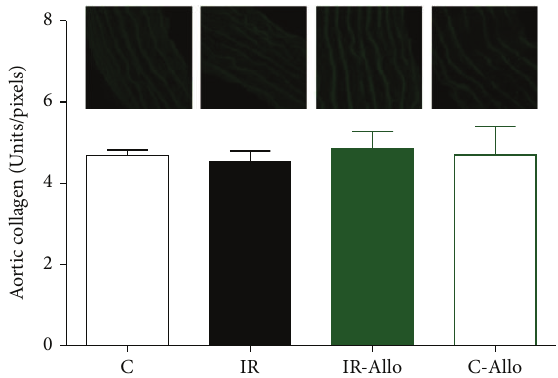
Figure 8: The effect of allopurinol (Allo) treatment on insulin resistance (IR) induced collagen changes, measured in Units/pixels. Values are expressed as the mean ± SEM; 𝑁 = 6 – 8 animals, with no significant changes by One-Way ANOVA and Newman-Keuls post hoc